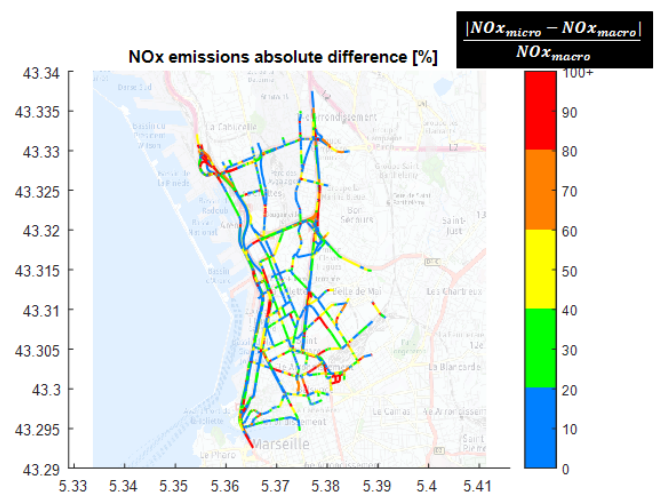
Figure 16. NO x emissions relative difference between the proposed model and COPERT.